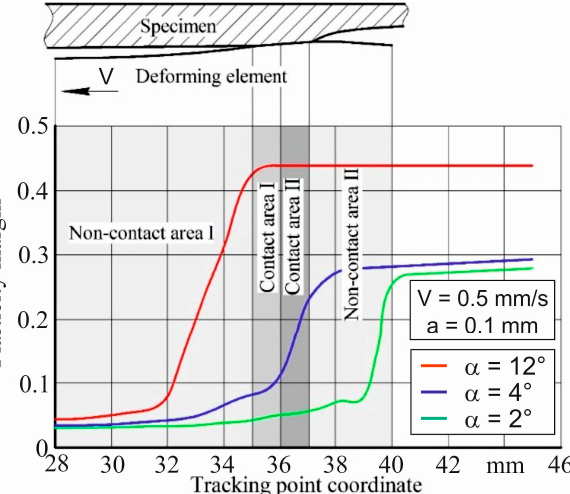
Figure 14. Dependence of the resource of plasticity ψ used on the tracking point coordinate.